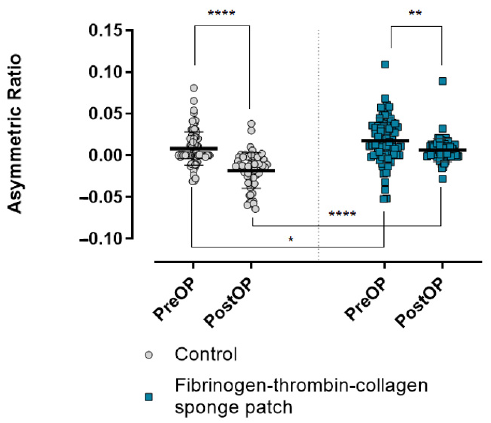
Figure 5. Comparison of the facial asymmetry between the control group and the fibrinogen-thrombin-collagen sponge patch group. The facial asymmetry ratio is displayed on the graph. The asymmetric ratio was calculated by the following formula: Asymmetric ratio = The ratio of the surface area of the operated side to the total face surface area-0.5. Values higher than zero mean that operative side protrudes more than the other side. The difference in the facial asymmetry ratio after the surgery was significantly less in the fibrinogen-thrombin-collagen sponge patch group than in the control group. NS, not significant; * p < 0.05; ** p < 0.01; **** p < 0.0001.